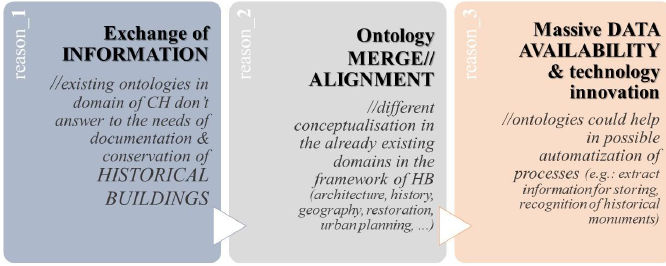
Figure 1. General reasons and scopes for an ontology